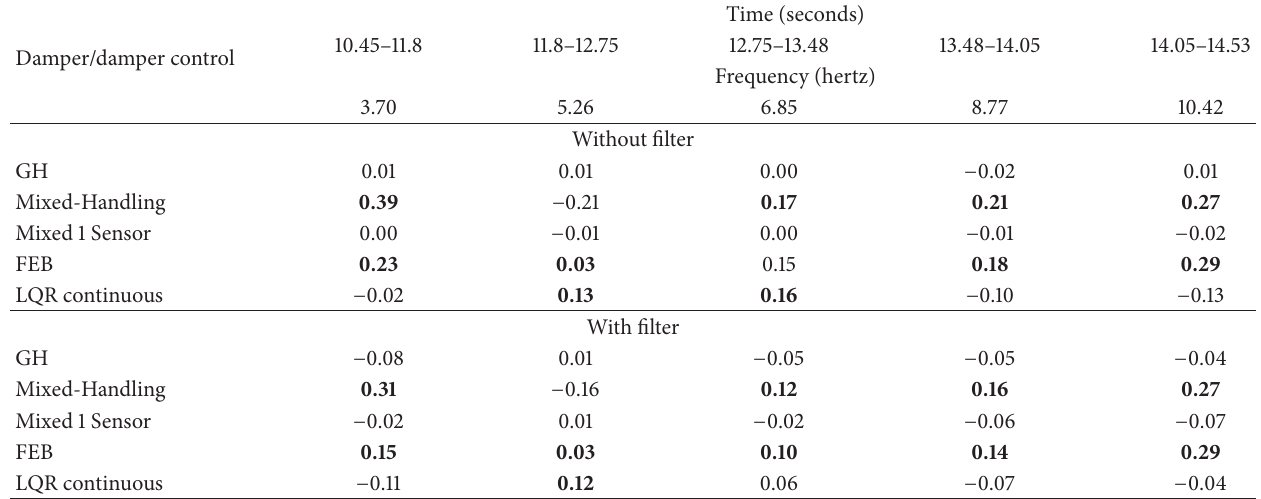
Table 5: BOGGS test, full throttle acceleration improvement index (higher is